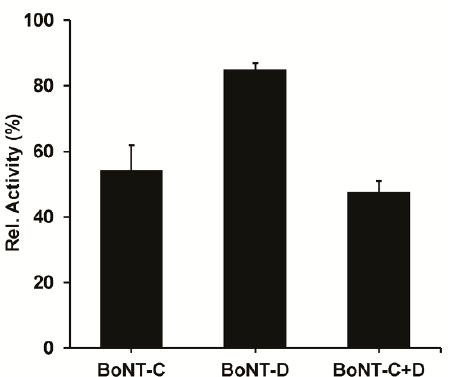
Figure 4. Reflective-based response of the immunological recognition assay for evaluating real BoNT samples. They averaged relative activity values of the different toxins, including selectivity evaluation. Data are reported as mean ± SD ( N = 3).